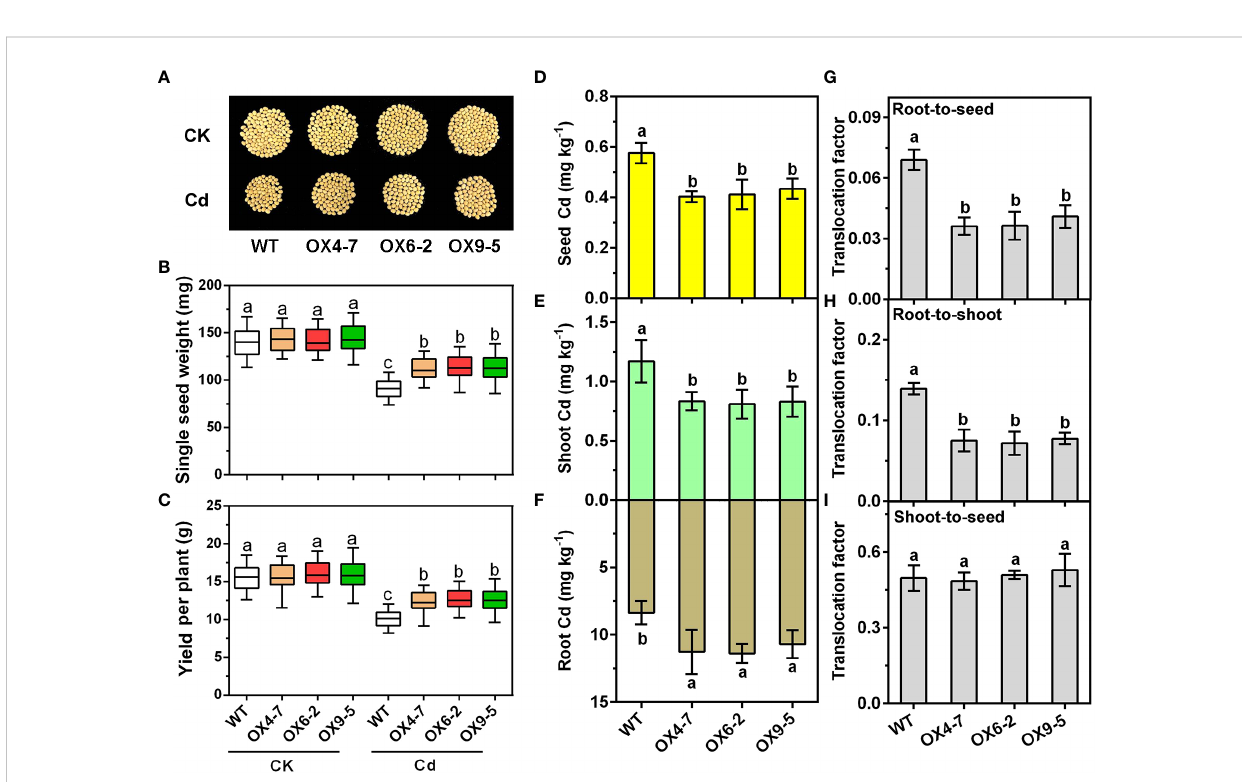
FIGURE 4 Overexpression of GmWRKY172 reduced Cd accumulation in seeds of the soybean. Phenotypes of mature seeds (A) , single seed weight (B) , and yield per plant (C) of WT and GmWRKY172 -OX lines under normal or Cd-treated conditions ( n = 20). Cd contents in seed (D) , shoot (E) , and root (F) of WT and transgenic lines were measured after 90 days of Cd treatment. The root-to-seed (G) , root-to-shoot (H) , and shoot-to- seed (I) translocation factor of Cd in the WT and transgenic lines. Data are expressed as mean ± SD, n = 3 (D – I) . Different letters indicate statistical signi fi cance determined by one-way analysis of variance and Duncan ’ s test ( P ≤